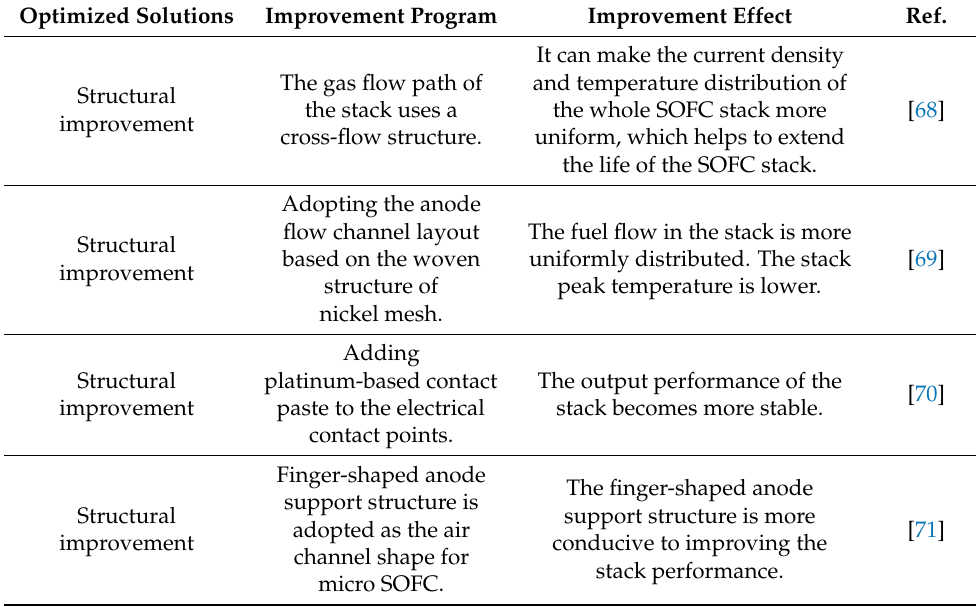
Table 5. SOFC performance optimization scheme based on structural